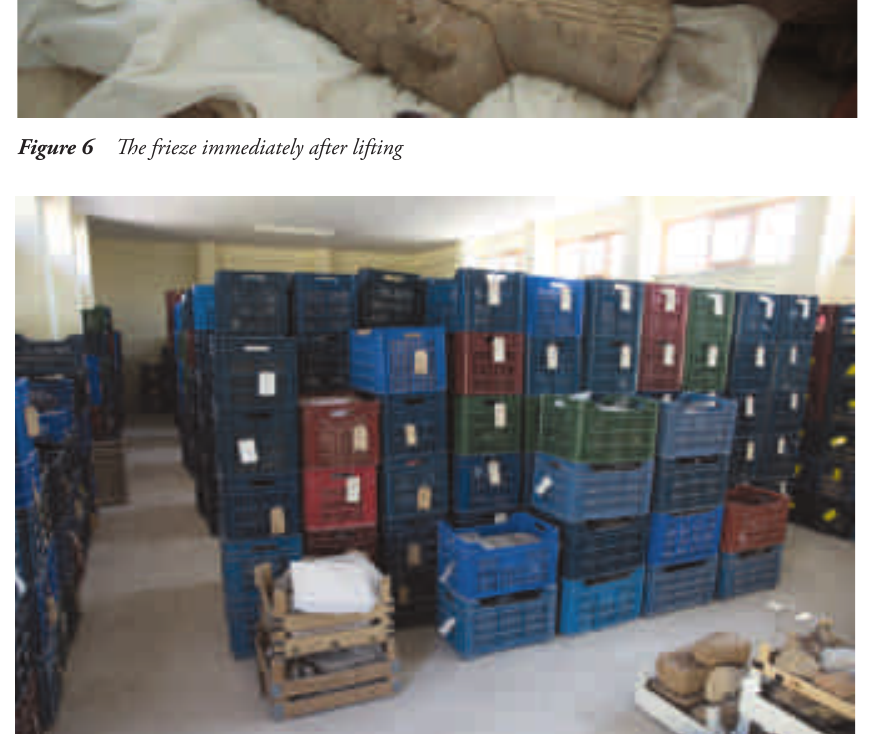
Figure 7 Part of the stored site